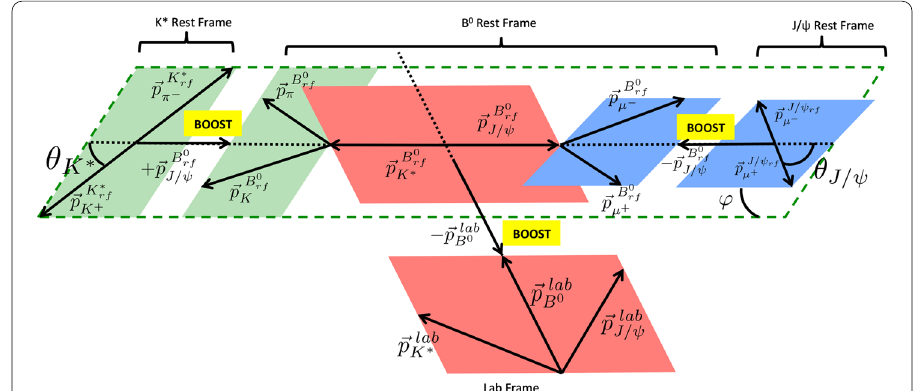
Fig. 1 A sketch illustrating the definition of two independent angular variables, θ J /ψ and ϕ , for the amplitude analysis of B 0 → J /ψ K π